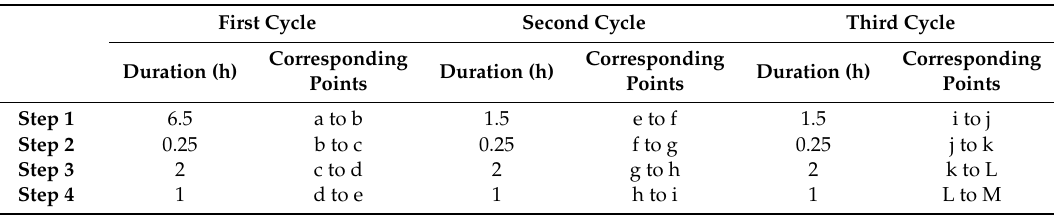
Figure 8. Temperature distributions at the ( a ) end of step 1 (point b in Figure 7), ( b ) end of step 2 (point c in Figure 7), ( c ) end of step 3 (point d in Figure 7), and ( d ) end of step 4 (point e in Figure 7) of the first thermal cycle of the steel ladle. Table 3. Summary of the three simulated thermal cycles of steel ladle, time period of each step, and corresponding points in Figure 7.